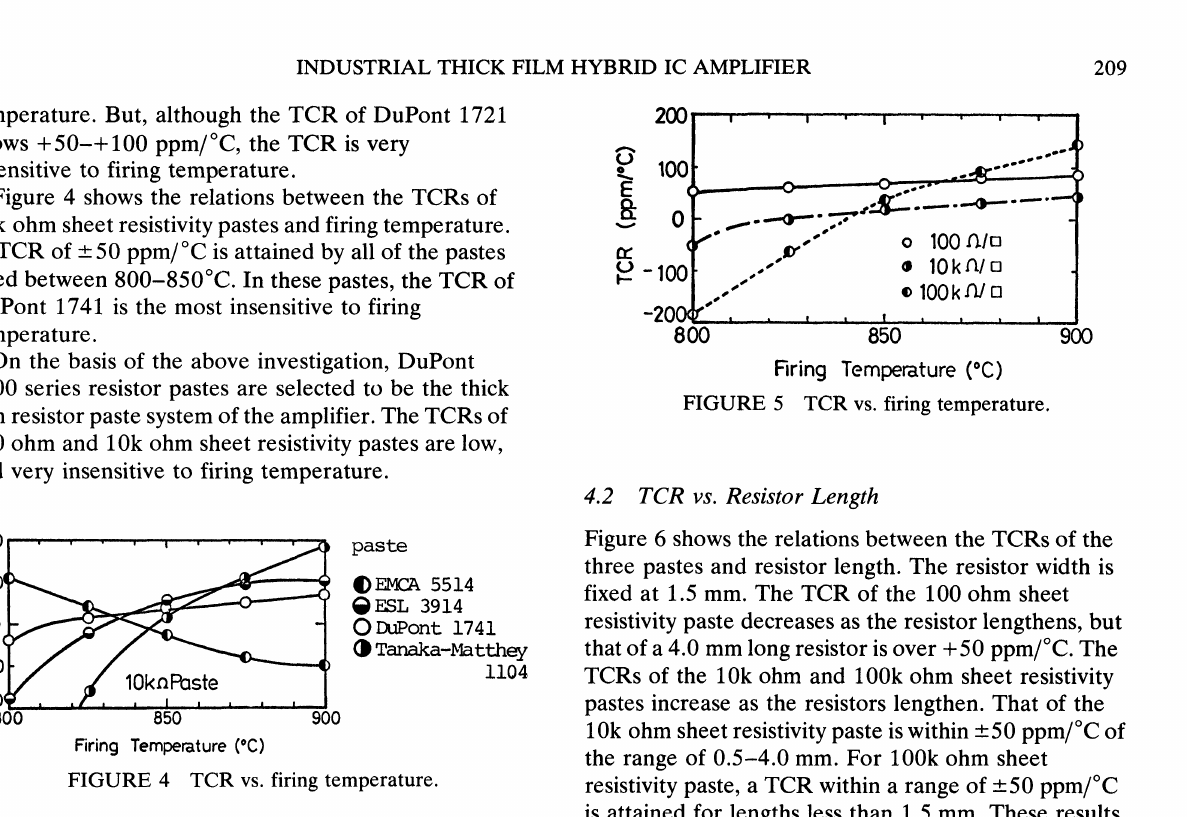
FIGURE 4 TCR vs. firing temperature.